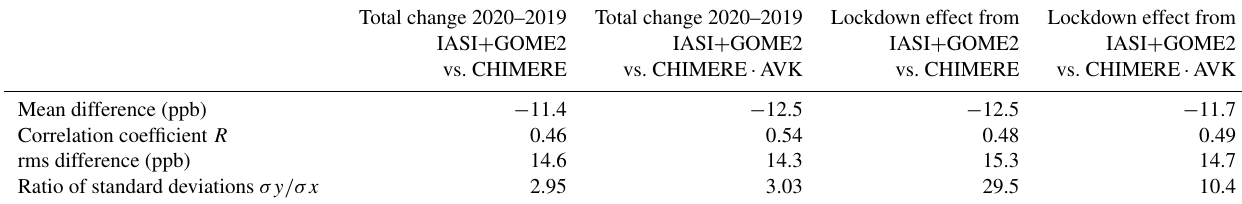
Table 3. Same as Table 2 but comparing CHIMERE simulations with respect to the IASI + GOME2 lowermost tropospheric ozone retrievals. All CHIMERE model simulations correspond to LMT ozone columns coincident with IASI + GOME2 retrievals on a daily basis. The indi- cation “ · AVK” is used when smoothing by the averaging kernels of IASI +